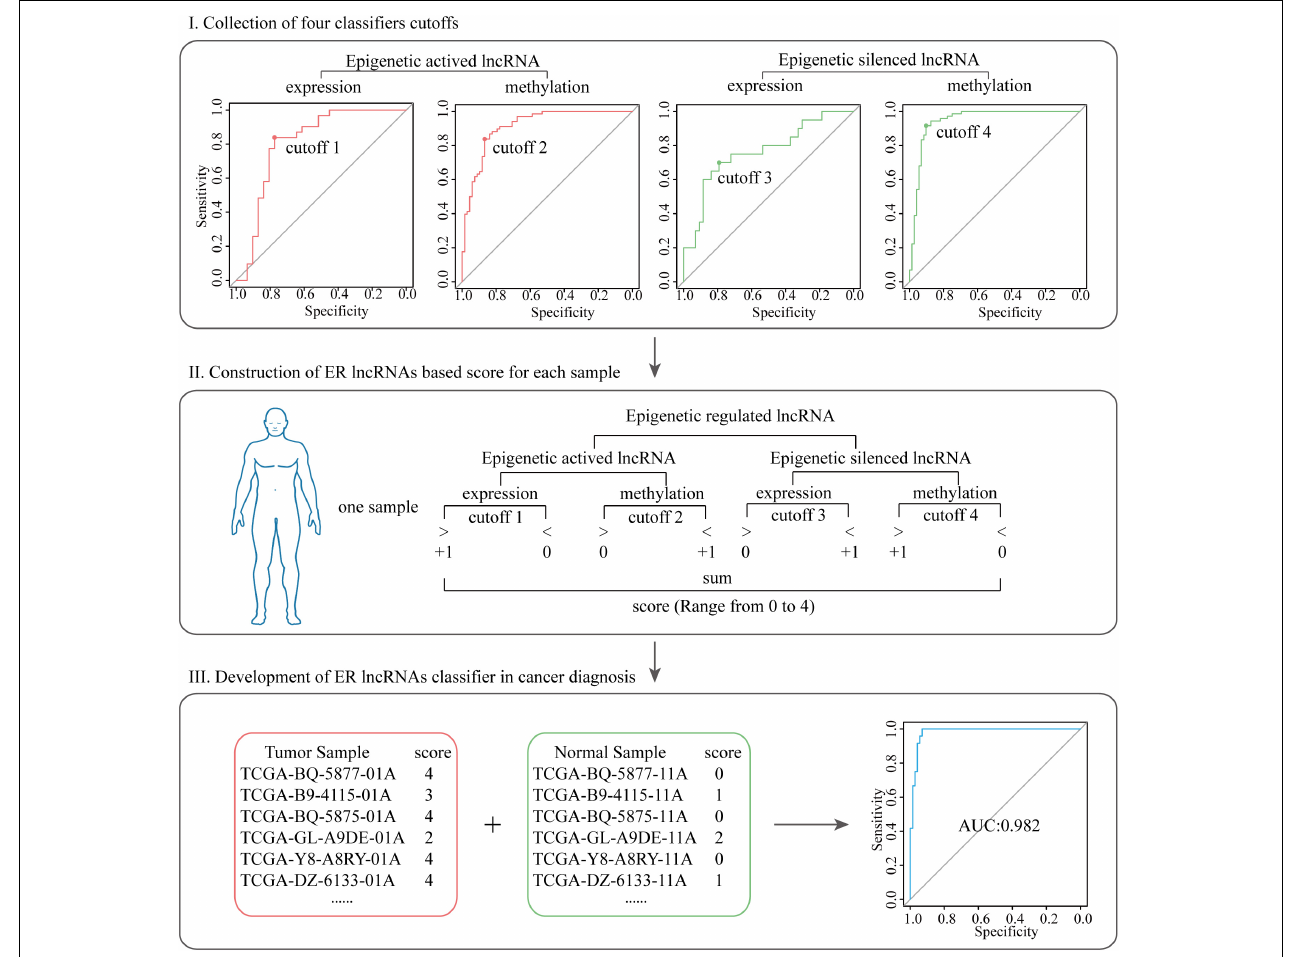
FIGURE 2 | The pipeline of developing ER lncRNA-based scores in cancer diagnosis. Step I: collection of four classifier cutoffs based on the expression and methylation of EA and ES lncRNA, respectively. Step II: construction of ER lncRNA-based scores for each sample. Step III: development of ER lncRNA classifier in cancer diagnosis.